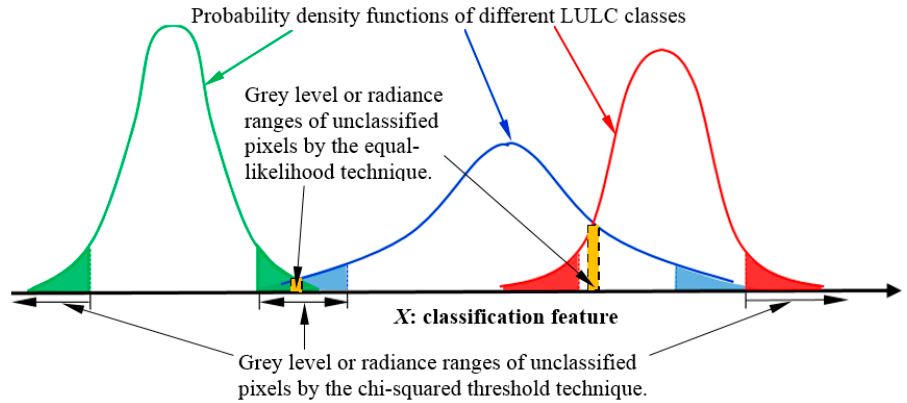
Figure 1. Illustration of the ranges of the classification feature of unclassified pixels identified using the chi-square threshold and equal-likelihood techniques.